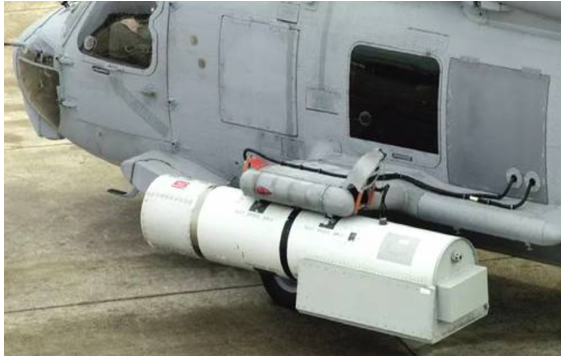
Figure 2. Magic light Airborne Laser Mine Detection System Installed on MCH-101 Sea Devil Helicopter (courtesy: